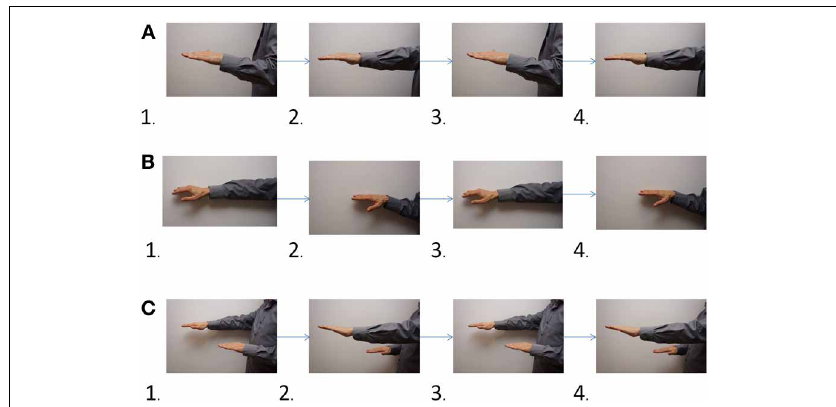
FIGURE 1 | Demonstrating separate and unified bimanual movement mental coding. Instructions: first practice each hand alone: (A) left hand movement (B) right hand movement. Now, try to combine the movements of both hands you rehearsed in stages (A) and (B) . Now try to imitate the movements shown in section (C) , which demonstrates the resulting bimanual movement. You would probably find it easier to start directly with bimanual movement, than to try to combine the movements of each hand which were rehearsed